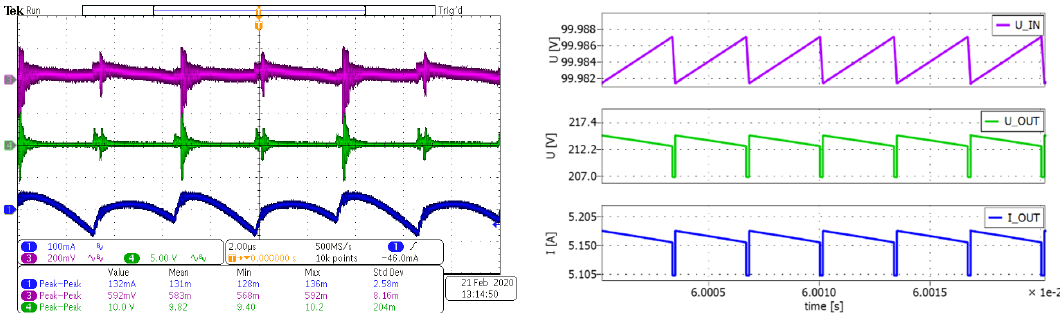
Figure 13. Time waveforms of input voltage ripple (violet), output voltage ripple (green), and output current ripple of the non-modular Bi-BB converter for experimental measurement sample ( left ) and simulation ( right ) in boost mode.